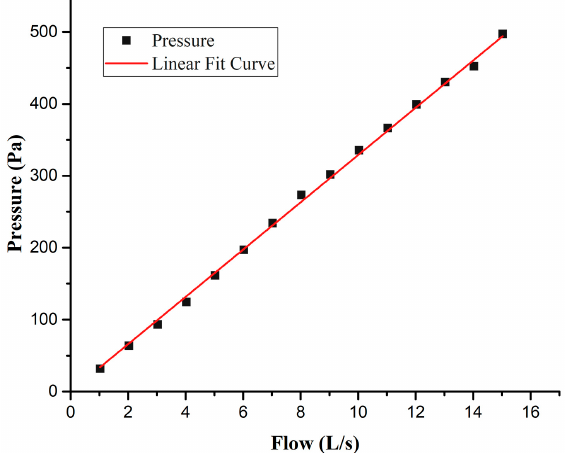
Figure 6. The handheld wireless flowhead and the smartphone displaying the results of the spirometry.